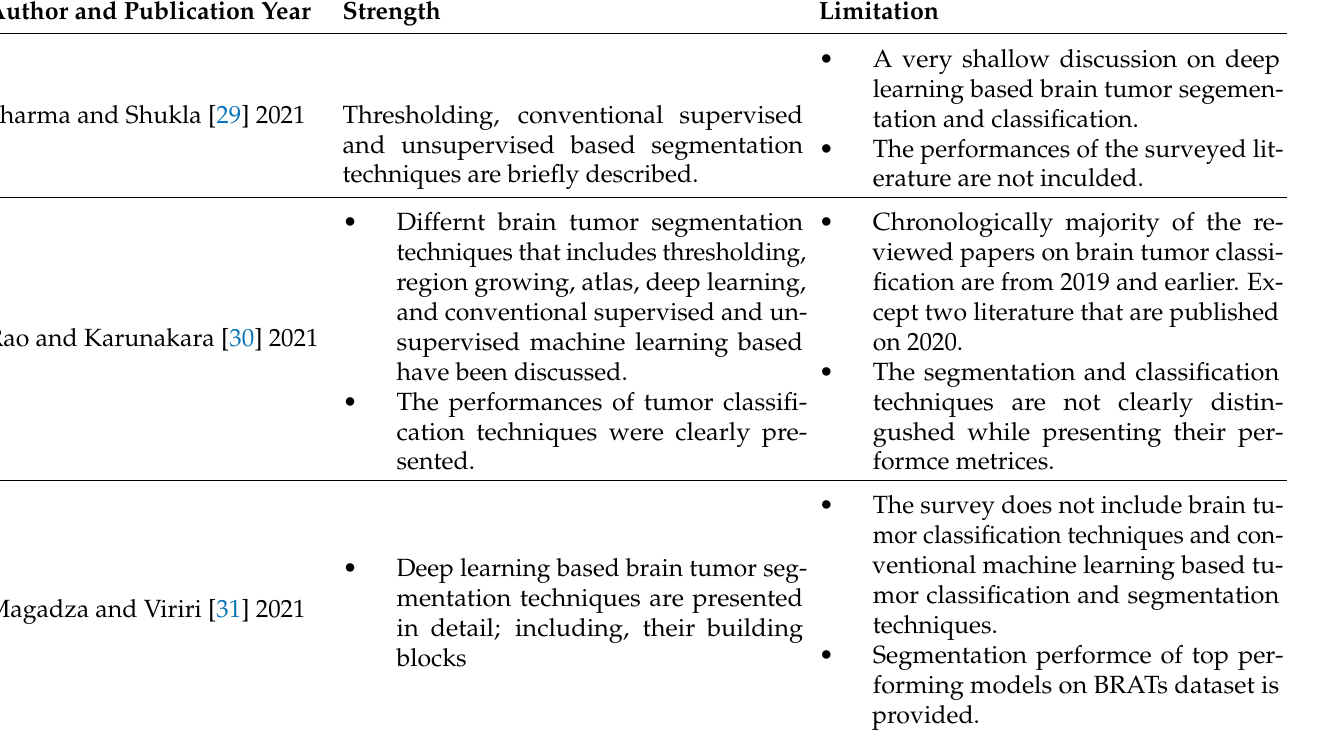
Table 1. Survey literature on brain tumor segmentation and classification